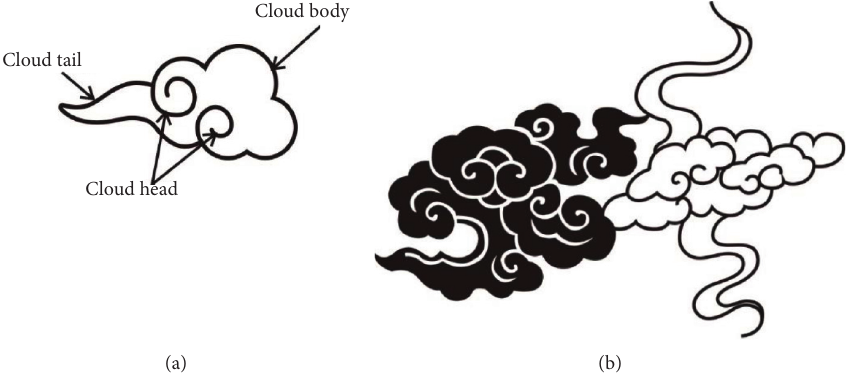
Figure 1: The composition of multimedia art patterns. (a) Cloud pattern decomposition. (b) Complex structure.